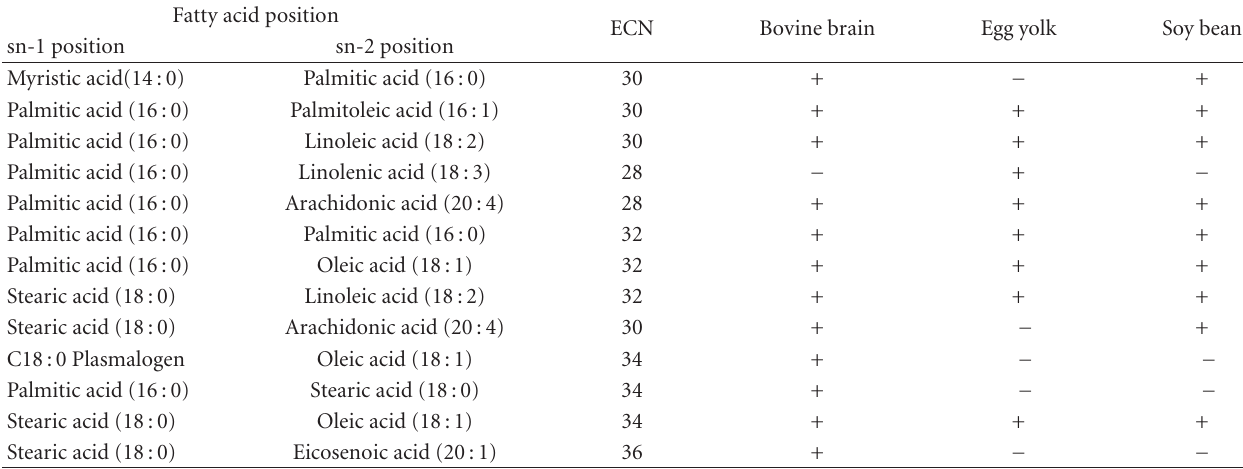
Table 2: Identified PC compounds within extracts of bovine brain, egg yolk, and soy bean. Fatty acid position ECN Bovine brain